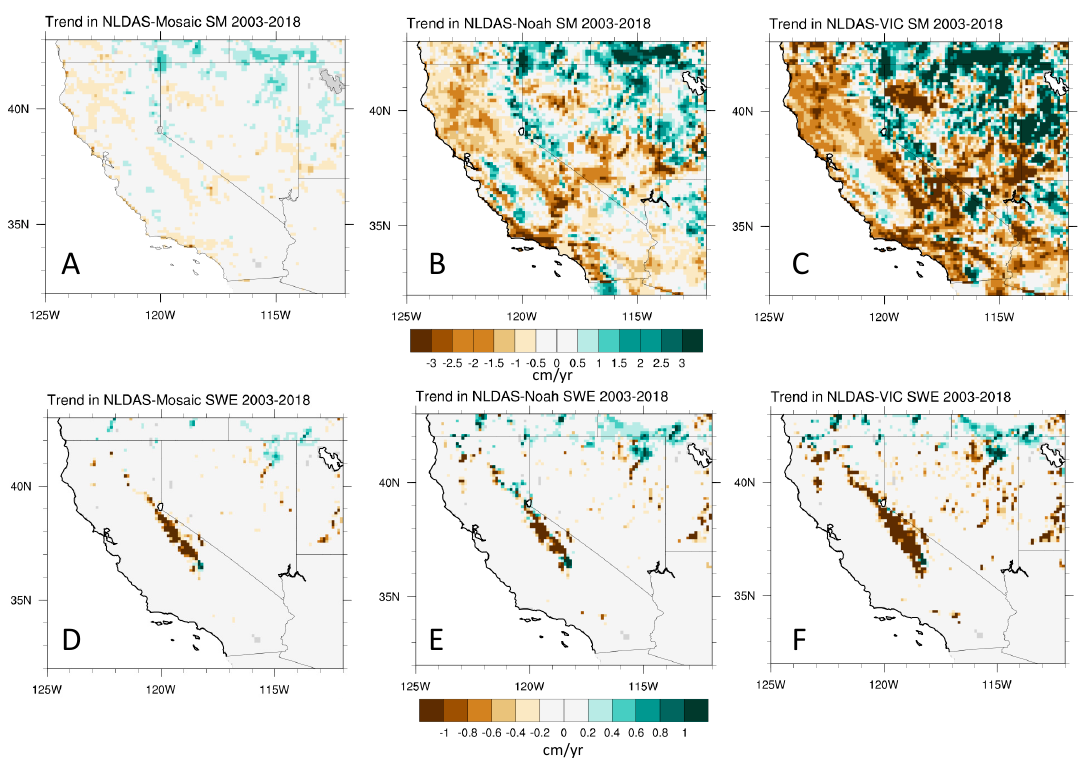
Figure 2. Trends in soil moisture (SM) and snow water equivalent (SWE) simulated by the NLDAS suite of models. ( A , D ) The Mosaic model. ( B , E ) The Noah model. ( C , F ) The VIC model.